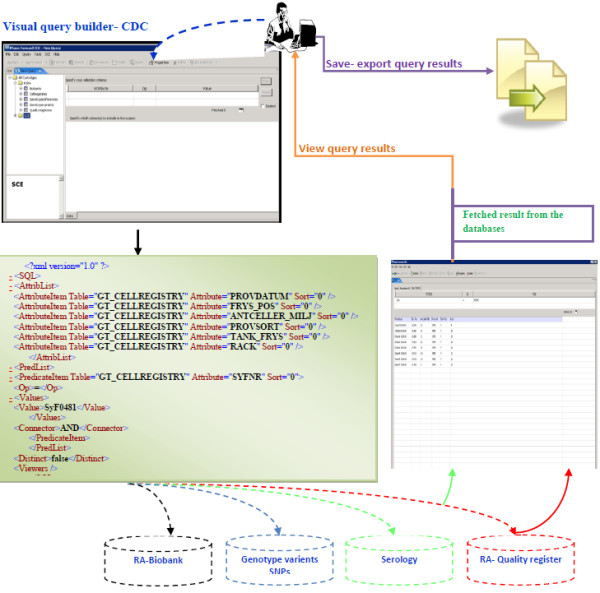
Visual query builder implementation in CDC.